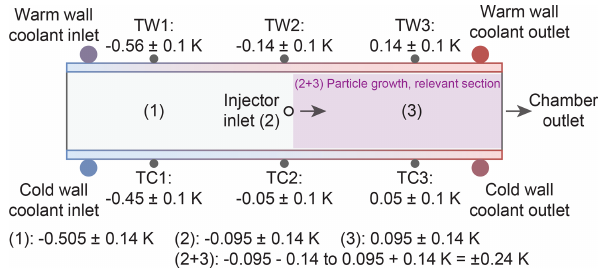
Figure 7. Schematic of uncertainty in temperature measurement showing a side view of HINC-Auto. TW and TC refer to one of six thermocouples installed on the warm wall and cold wall, re- spectively. Positions (1), (2), (3) and (2+3) indicate the temperature uncertainty of the center lamina. For each of the positions (1, 2 and 3), we have the ± 0.1K form the warm and ± 0.1K from the cold Figure 8. Data from experiments in HINC-Auto and comparison (cid:112) wall thermocouple; thus, ± 0 . 1 2 + 0 . 1 2 K =± 0.14K. to values from literature for cloud droplet formation and homoge- neous freezing onset with ammonium nitrate and deliquescence of ammonium sulfate and sodium chloride. Reported is the activation particle concentration in parallel to HINC-Auto to obtain AF. onset when the signal increases above the background noise levels. Dashed line: homogeneous freezing onset of solution droplets for d 0 = 200nm and J = 10 10 cm − 3 s − 1 (Koop et al., 2000b).